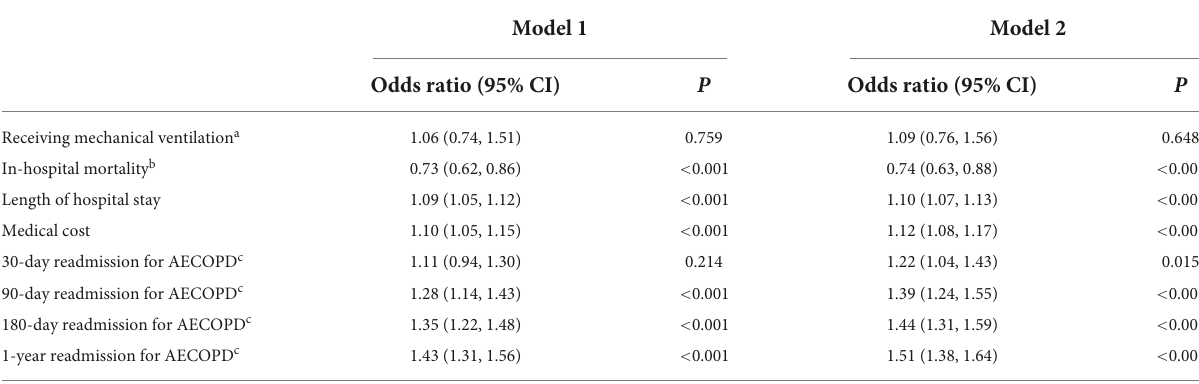
TABLE 4 The multivariate analyses of the associations between depression or anxiety and patients’ in-hospital outcomes and the risks of readmission for AECOPD after discharge. Model 1 Model 2 Odds ratio (95% CI) P Odds ratio (95% CI) P